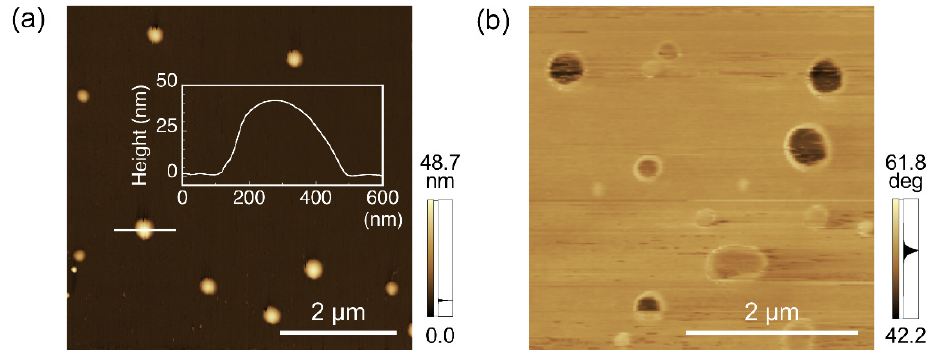
Figure 3. Atomic force microscopy (AFM) observation of the biocomposite nanoparticles using PPO and PPO-binding peptides. ( a ) Height image of biocomposite PPO nanoparticles prepared in the presence of the PPO-binding peptide. A representative cross-sectional analysis of the biocomposite nanoparticles is shown in the figure. ( b ) Phase image of biocomposite PPO nanoparticles observed in another position to ( a ).